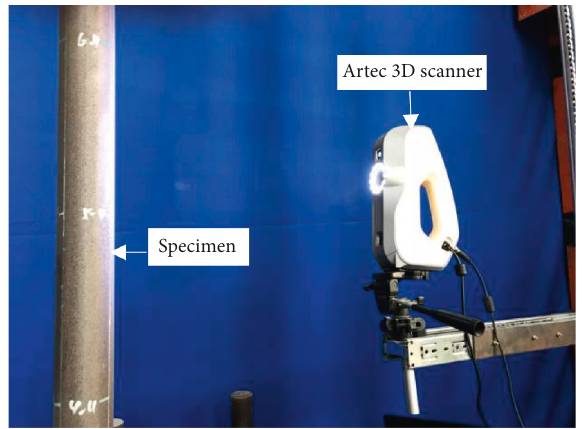
Figure 8: Artec 3D